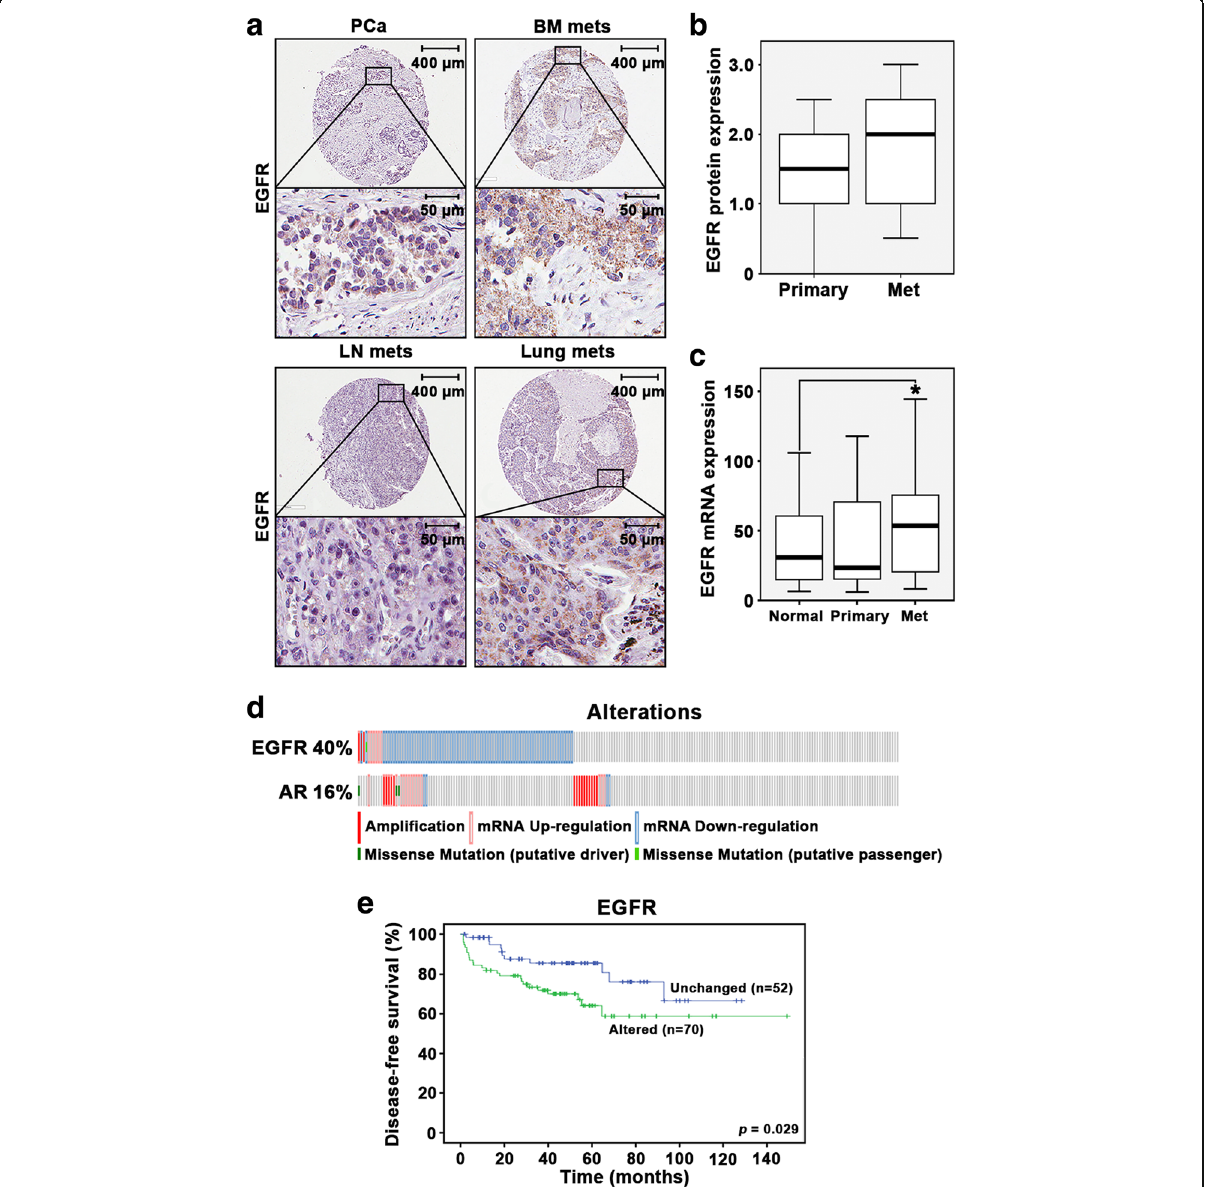
Fig. 1 Evaluation of the clinical importance of EGFR and its correlation with AR in prostate cancer patients. a Immunohistochemical analysis of EGFR expression in primary PCa ( n = 17), and in bone, lymph node and lung metastatic PCa sites ( n = 43). The TMA staining intensity shows that EGFR protein expression is highest in bone metastatic PCa lesions. b Box plot showed the comparison in EGFR protein expression between primary PCa ( n = 17) and metastatic lesions ( n = 43) ( p = 0.147). c Box plot showed the comparison in EGFR mRNA expression between normal prostate ( n = 58), primary PCa ( n = 64) and metastatic lesions ( n = 24) ( p = 0.05). d Gene and mRNA alteration profiles of EGFR and AR in PCa patients ( n = 216) where 40% of patients ( n = 86) exhibited EGFR alterations on the gene and mRNA level, while 16% of patients ( n = 35) exhibited discrepancies in AR gene and mRNA expression. MSKCC Prostate Oncogenome Database was used. e Kaplan-Meier survival curve revealed that patients with alterations in EGFR ( n = 70) suffered poorer disease-free survival (DFS) as compared to those without alterations ( n = 52), and this difference was statistically significant ( p = 0.029). MSKCC Prostate Oncogenome Database was